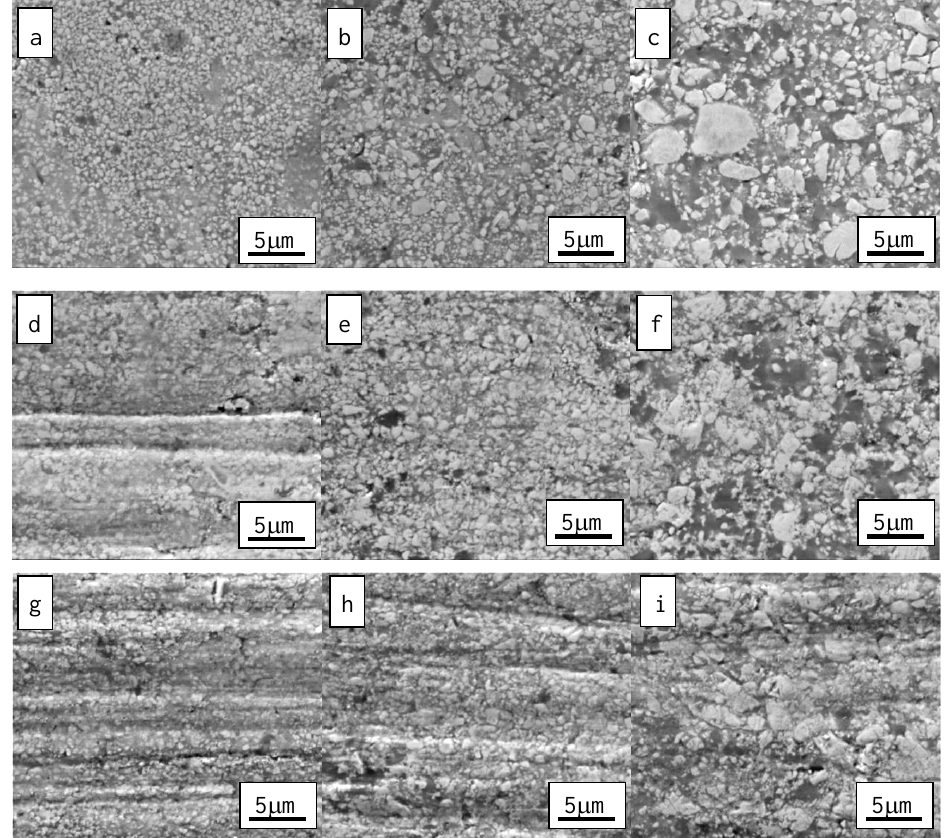
Figure 8. Typical worn surface morphologies of the three WC-20Cr 3 C 2 -7Ni coatings: ( a – c ) three-body abrasive wear (180-mesh SiO 2 abrasive); ( d – f ) three-body abrasive wear (180-mesh SiC abrasive); ( g – i ) two-body abrasive wear (180-mesh SiC sandpaper); ( a , d , g ) FC coating, ( b , e , h ) MC coating, ( c , f , i ) CC coating.